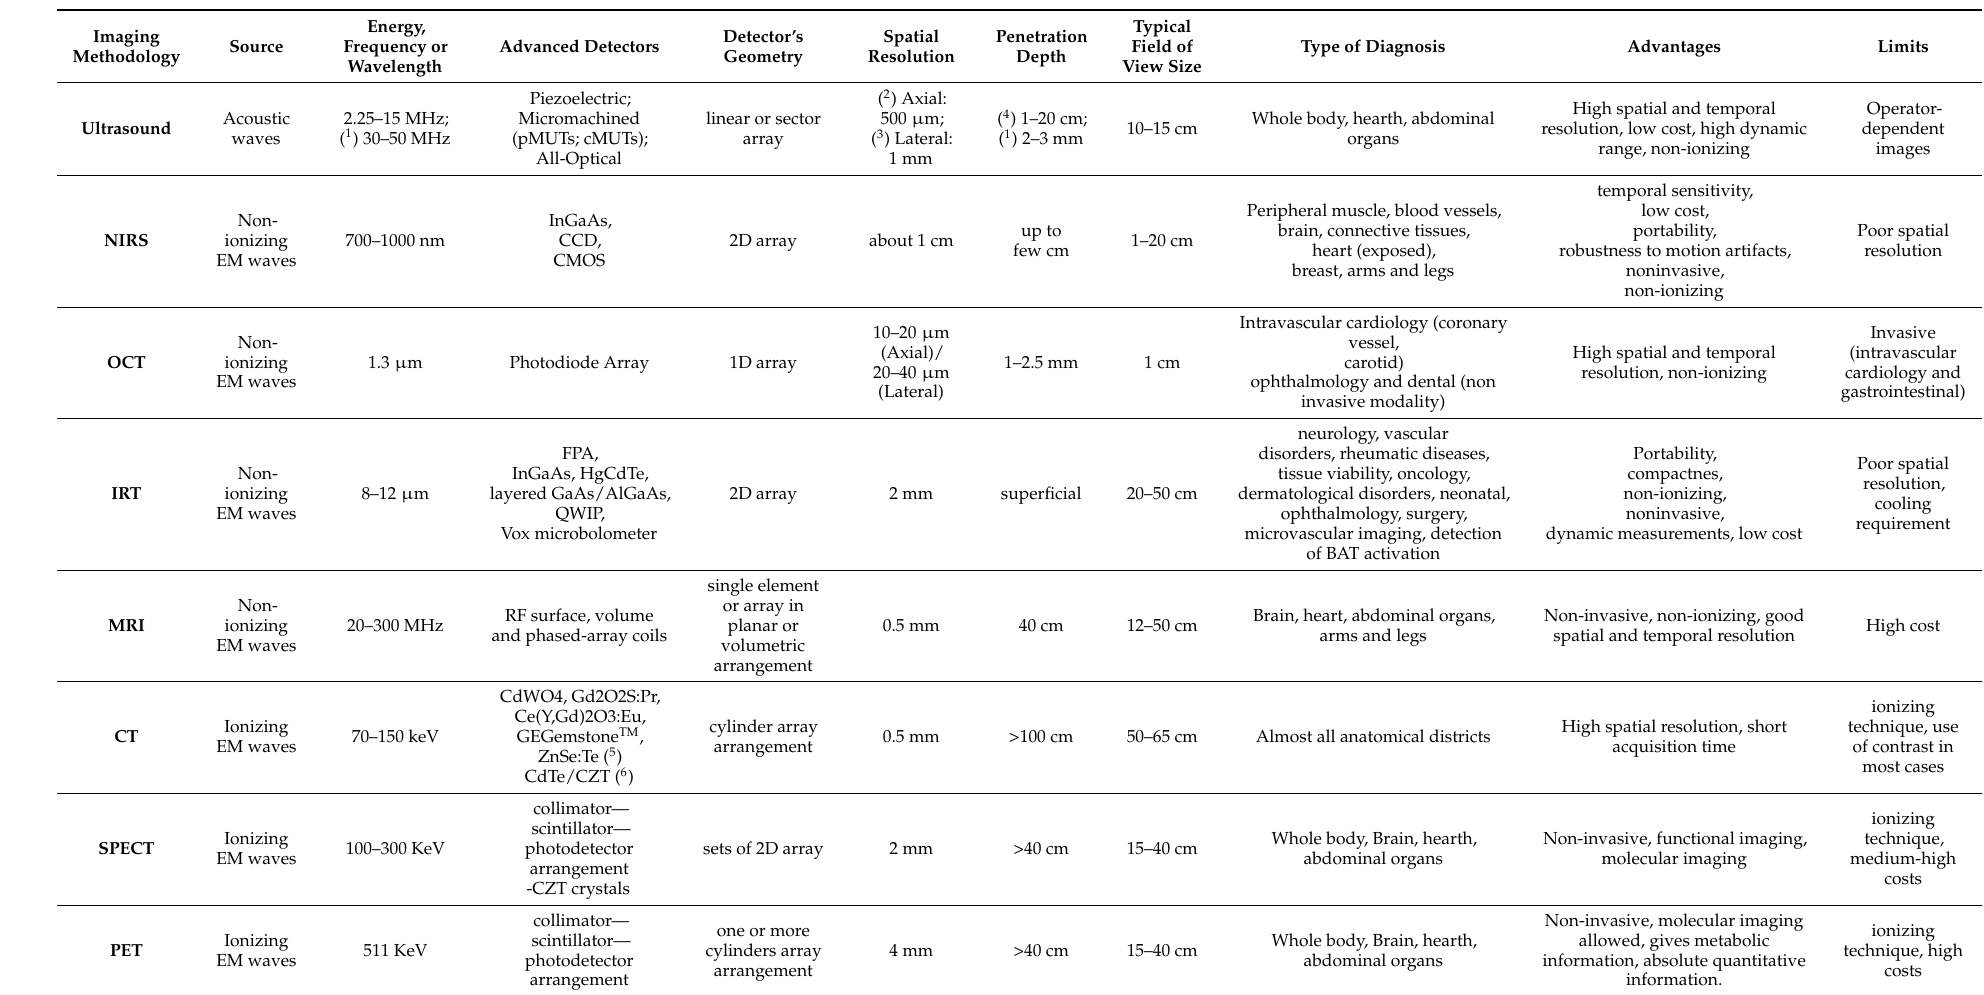
Table 1. Comparison between imaging